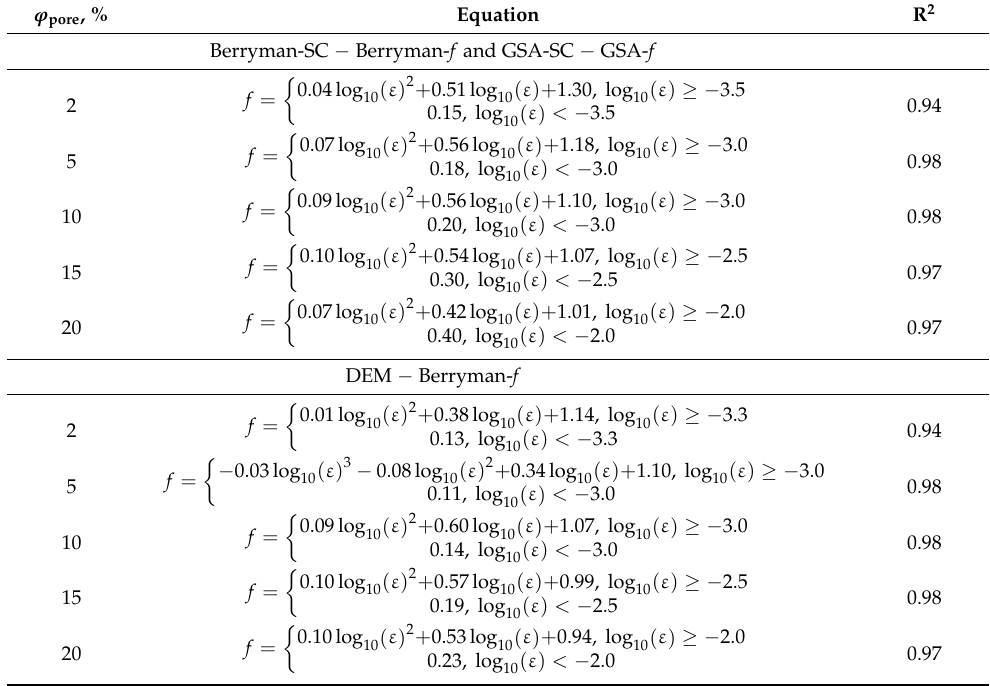
Table 2. Relationships between the crack density and f -parameter for fixed spherical porosity values for the case of gas-saturated voids. The R 2 is the coefficient of